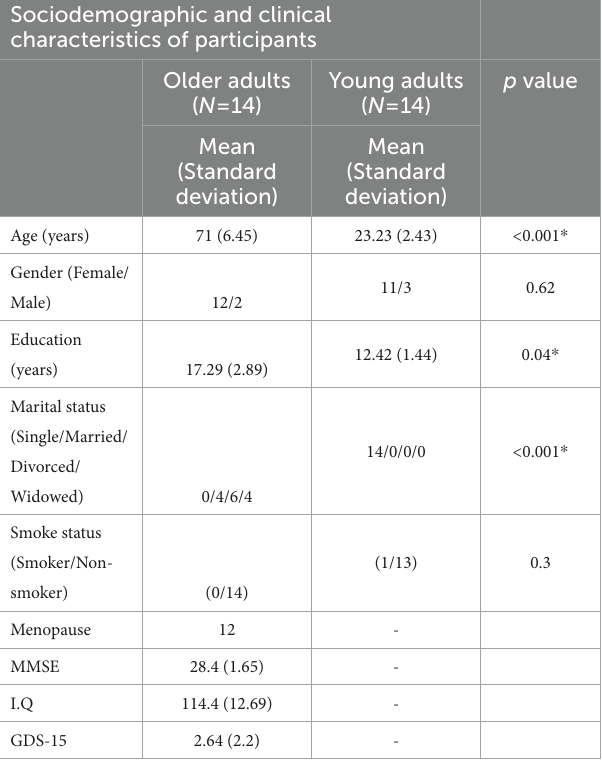
TABLE 1 Sociodemographic data about older adults and young adults. Sociodemographic and clinical characteristics of